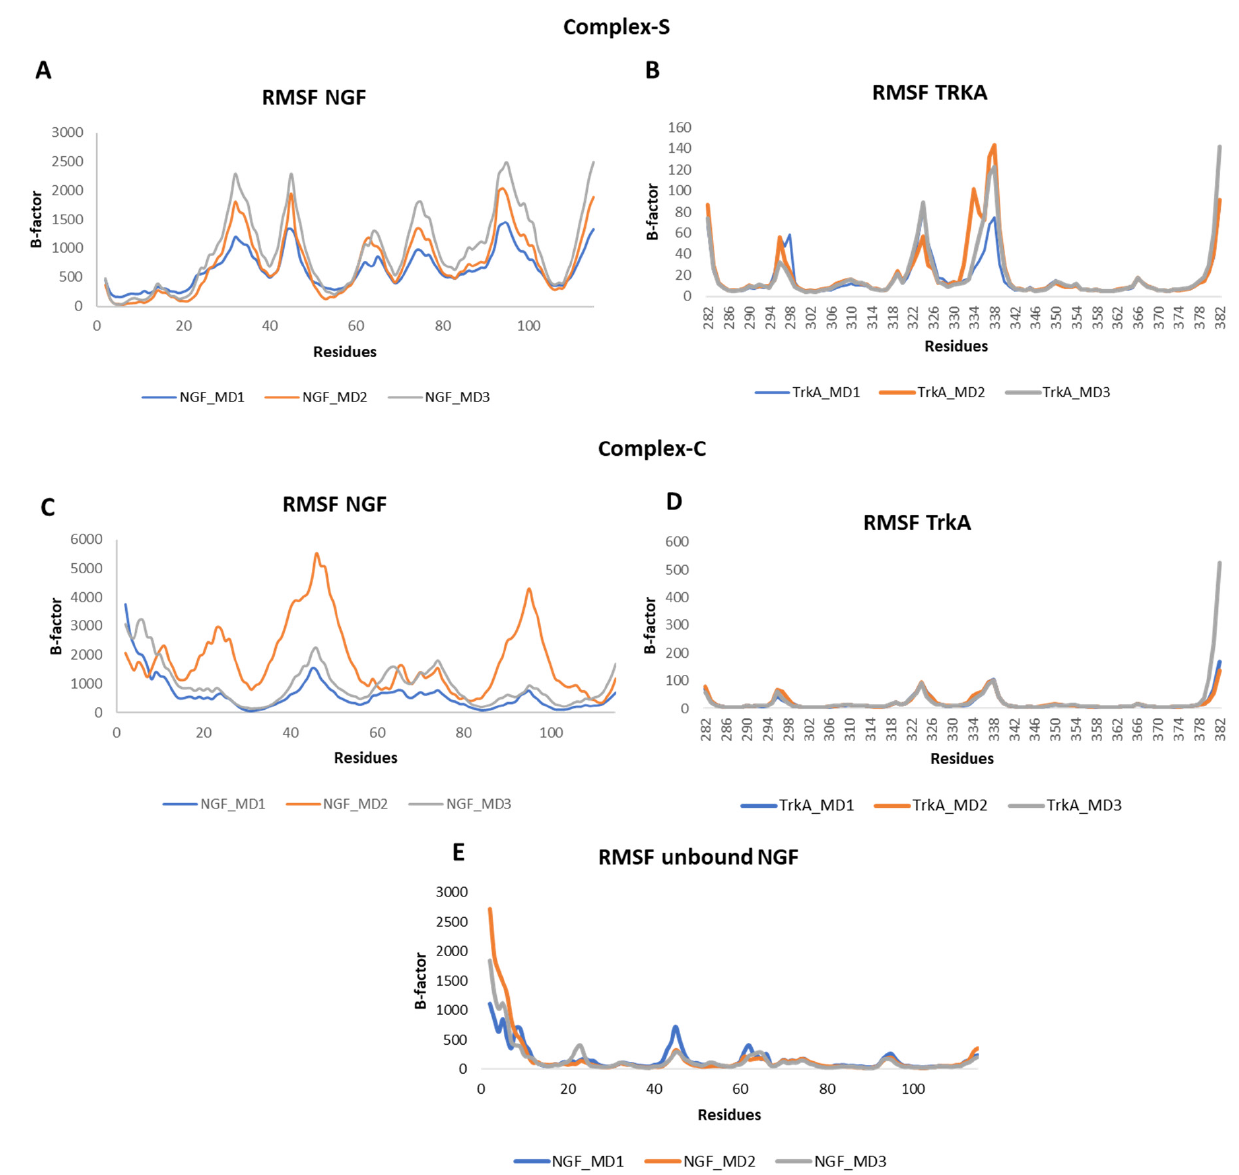
Figure 5. RMSF profiles of NGF and TrkA backbones registered in the three MD runs performed on complex-S ( A , B ), complex-C ( C , D ) and the unbound NGF ( E ). complex-S ( A , B ), complex-C ( C , D ) and the unbound NGF ( E